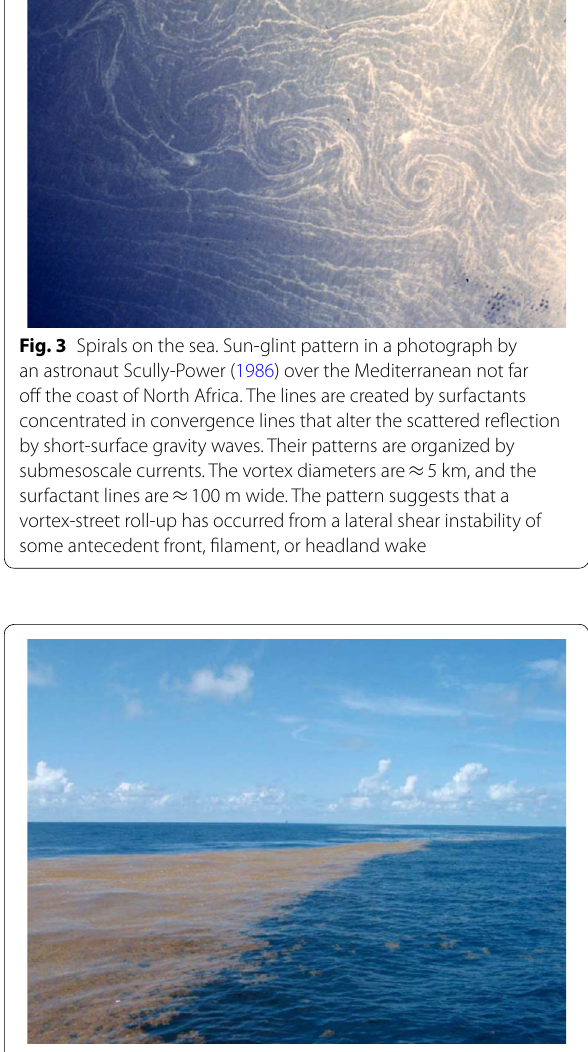
Fig. 4 Surface convergence line. A fantail view of a ≈ 10 m-wide line of buoyant sargassum weed in the Gulf of Mexico concentrated by a submesoscale frontal secondary circulation (Gower et al. 2006). Notice the along-front extent away into the distance, with a